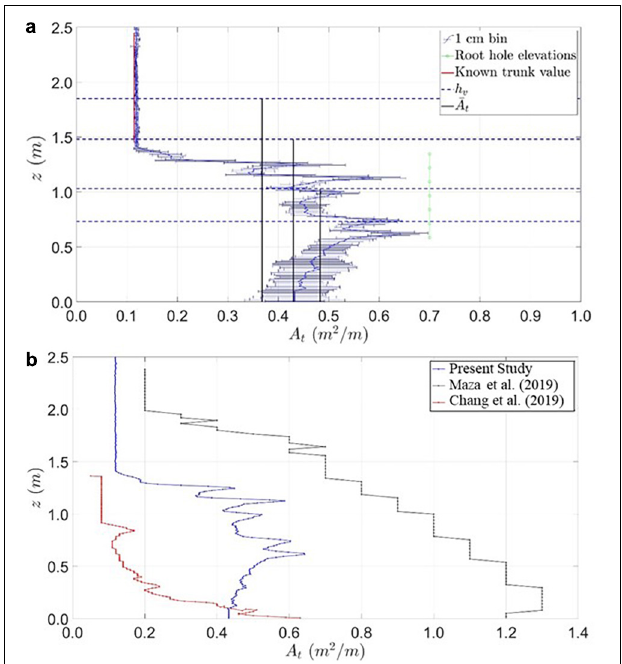
FIGURE 6 | (a) Projected area per unit height per tree, A t , versus the water depth at the vegetation, h v , for the high-density (HD) mean half stencil. Error bars represent one standard deviation and vertical lines show mean projected area per unit height per tree, A t . (b) Comparison of the projected area per unit height per tree, A t , for high-density (HD) mean half stencil (blue line and markers), prototype-scale Maza et al. (2019) (black line and markers), and prototype-scale Chang et al. (2019) (red line and markers) model tree profiles. Note change in x- axis scale from (a) to (b) .